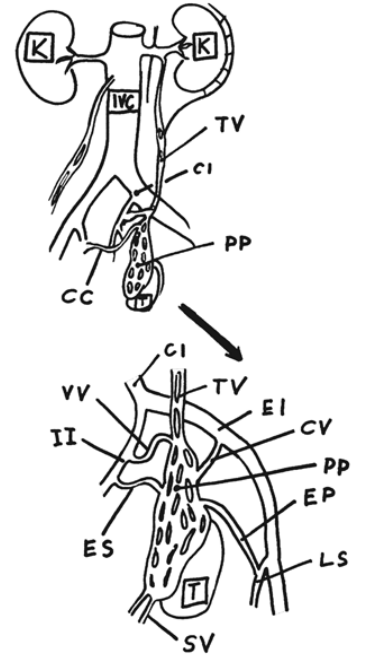
FIGURE 1 . Anatomy of venous drainage from left